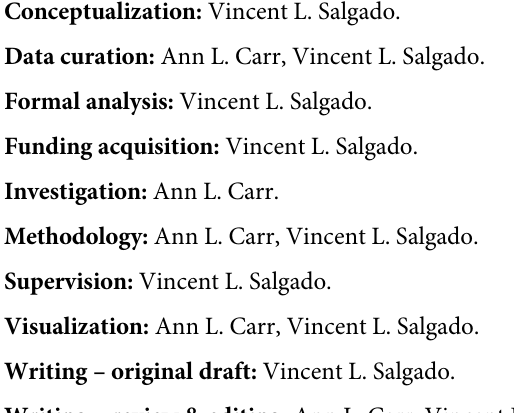
Bottom: warm plate at 40 ˚C in the presence of 50 ng/cm 3 DEET. Initially, four ticks go right, three go left and one stays in middle initially but then moves left after a delay. Final choice scores are 1 cold plate, 1 warm plate and 6 neither. S1 Table. Statistical analysis of all thermotaxis data scored as choice tests.